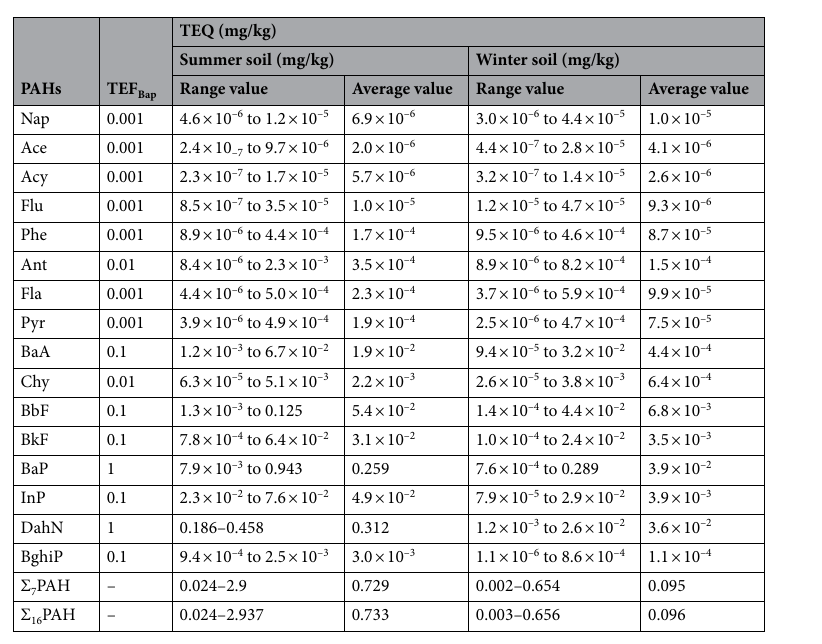
Table 3. Toxicity equivalent concentration of PAHs in the soil of parks in Urumqi. Σ 7 PAHs: 7 kinds of carcinogenic PAHs (BaA, Chr, BbF, BkF, BaP, InP, DahN); Σ 16 PAHs: 16 kinds of priority control